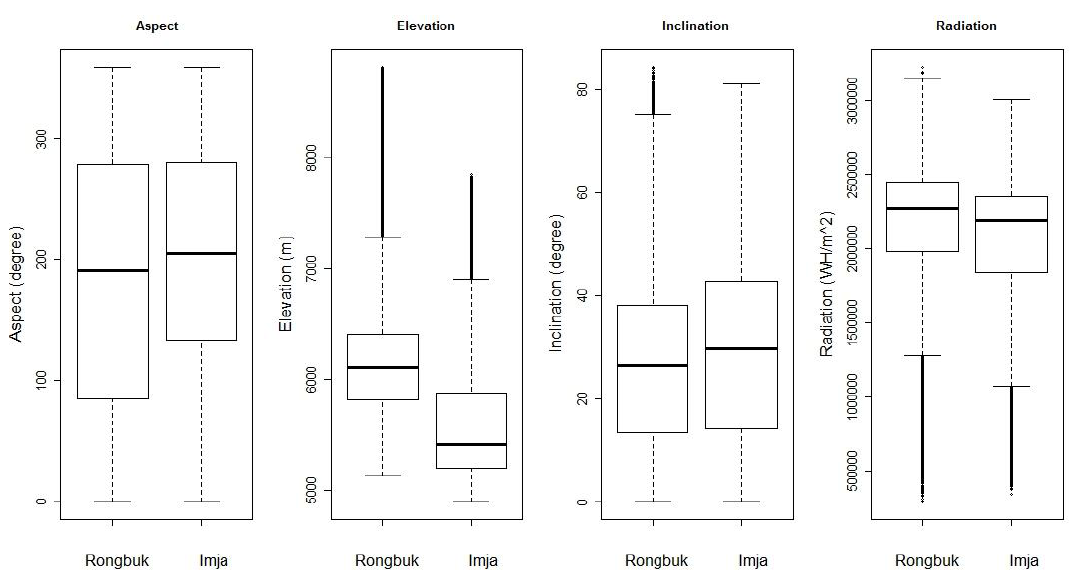
Figure 7. Boxplots of topographic conditions of Rongbuk Lake and Imja